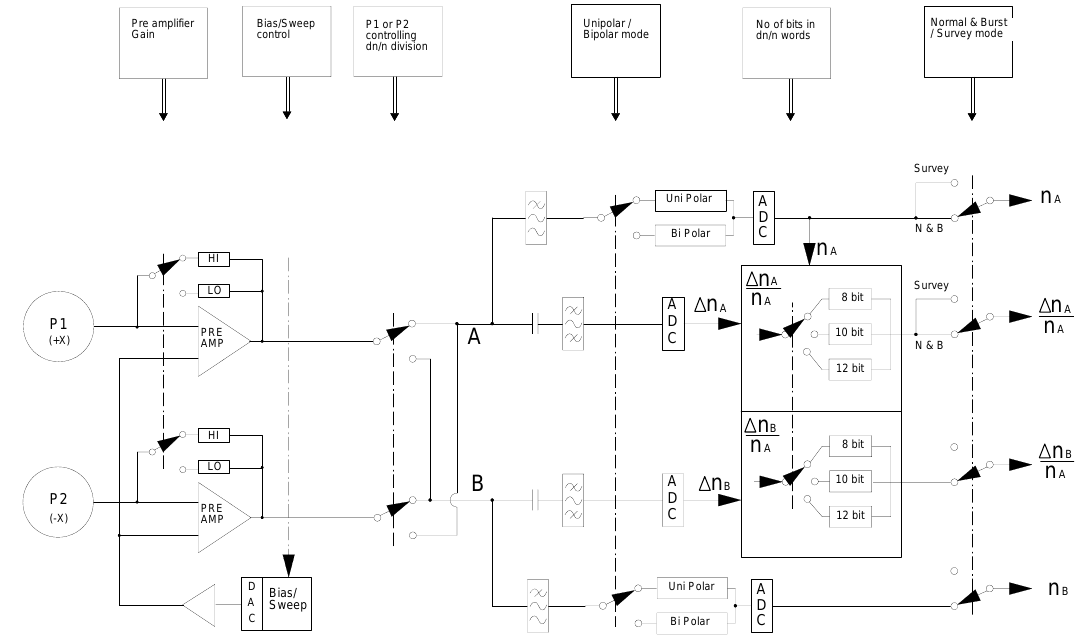
Fig. 7. Graphical representation of the LINDA signal handling showing the different hardware alternatives for mode settings. Switches interconnected by dashed lines are always set